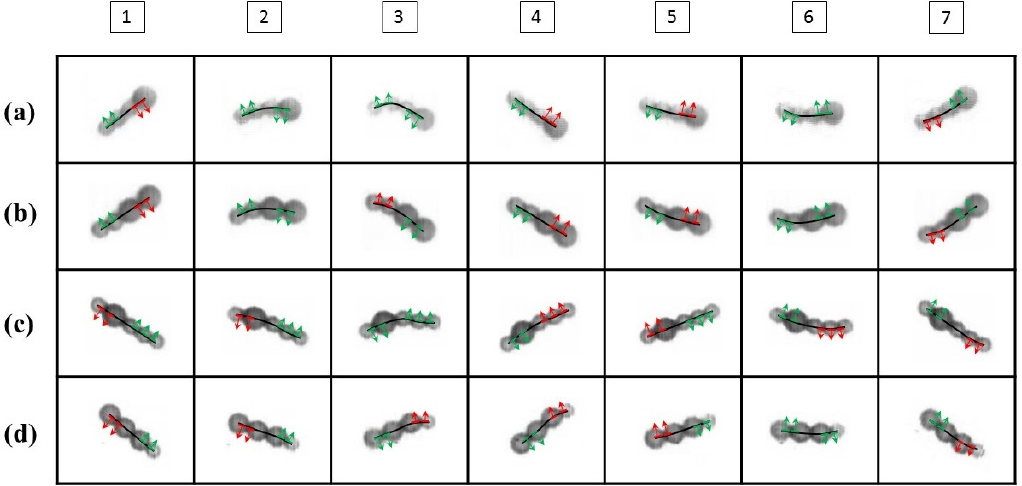
Figure 7. Schematic diagram of the forces imposed on the i th particle ( a ) when moving vertically along the axis of propulsion (x-axis) at the velocity of V i,y , or ( b ) when moving along the x-axis at the velocity of V i , x . In Figure 6, the L1S3, L2S2, and S1L1S3 swimmers generated the effective waveforms that are shown in images 2, 3, and 6. In contrast, the effective waveform of the L3S1 swimmer shown in image 6 exhibited insignificant flexibility. As a result, the different configurations led to variations in the net thrust of the swimmers. A comparison of the swimming effectiveness for the different types of swimmer is demonstrated in the next section. 3.4. Theoretical Equation for the Net Thrust of the Microbead Swimmer To theoretically study the propulsive force of a swimmer, a model was modified to calculate the forces acting on each microbead of the swimmer based on the resistive force theory of sperm motion [37]. The forces that act on one of the individual beads should reflect the forces imposing on the fluid. Figure 7 illustrates the forces imposed on the i th particle (denoted as P i ) when the swimmer moves along the axis of propulsion (x-axis). The orientation ( θ i ) of the i th particle to the axis of propulsion